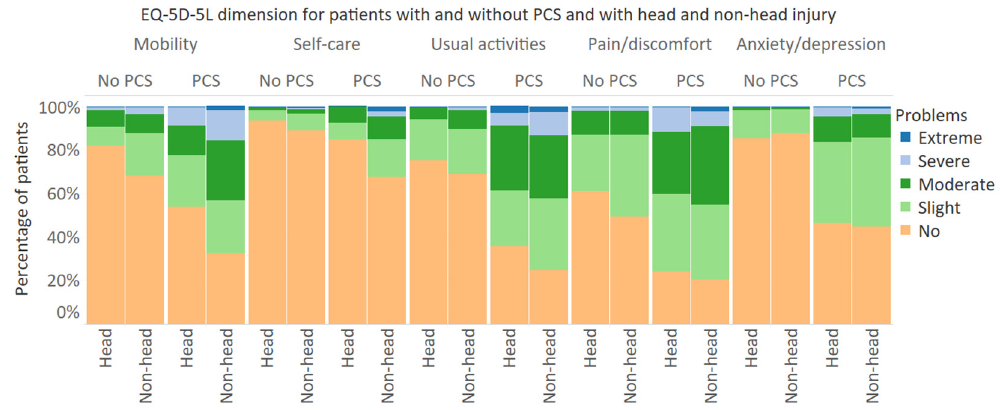
Figure 3. Frequency of responses to EQ-5D-5L of patients with and without head injury, by PCS status. PCS: Post-concussion syndrome ( ≥ 3 of the core post-concussion symptoms). Table 4. Health profile change over time according to Paretian classification for profiles changes, for total population and patients with and without post-concussion syndrome (PCS).